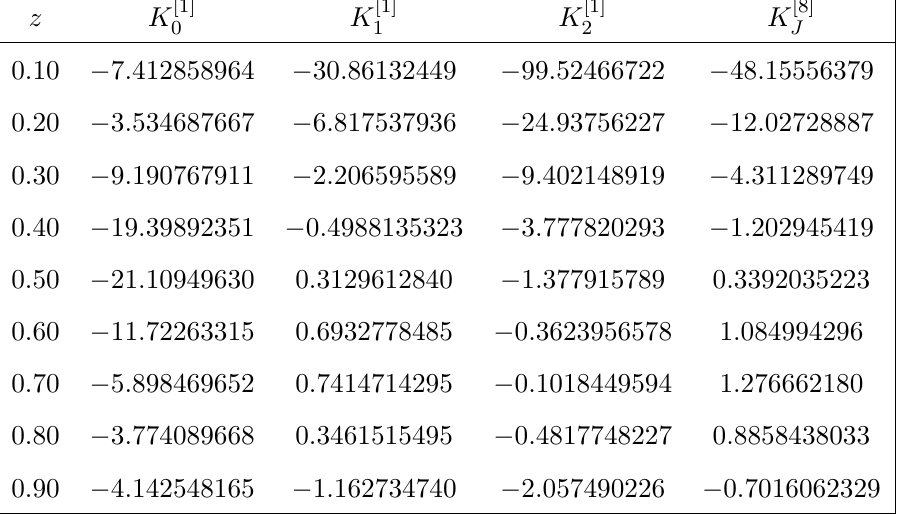
Table 1 . K-factors at different values of z for c ¯ c . K [ c ] and the symbol J means the sum of j = 0 , 1 , 2 .